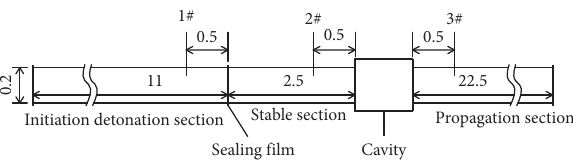
Figure 1: Numerical simulation geometric model (unit: